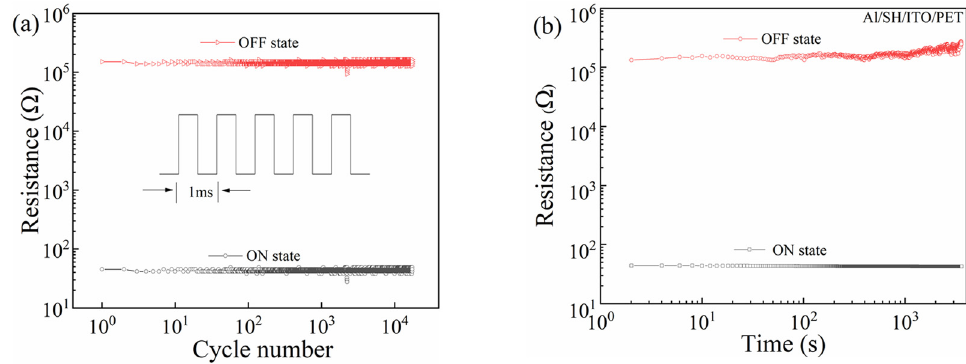
Figure 4. Al/SH/ITO/PET device: ( a ) pulse test and ( b ) retention time. The I-V characteristic curve of the Al/SH:GQD/ITO/glass device under DC voltage